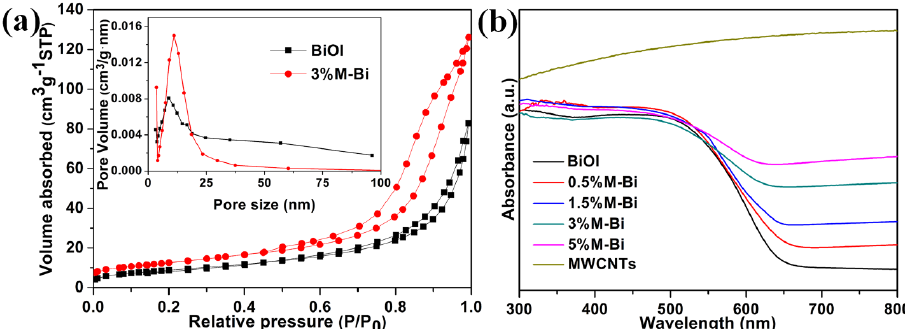
Figure 4. ( a ) N 2 adsorption/desorption isotherms of BiOI and 3%M-Bi; the inset is the corresponding pore size distributions; ( b ) UV-Vis reflectance spectra of BiOI, MWCNTs, and MWCNTs/BiOI